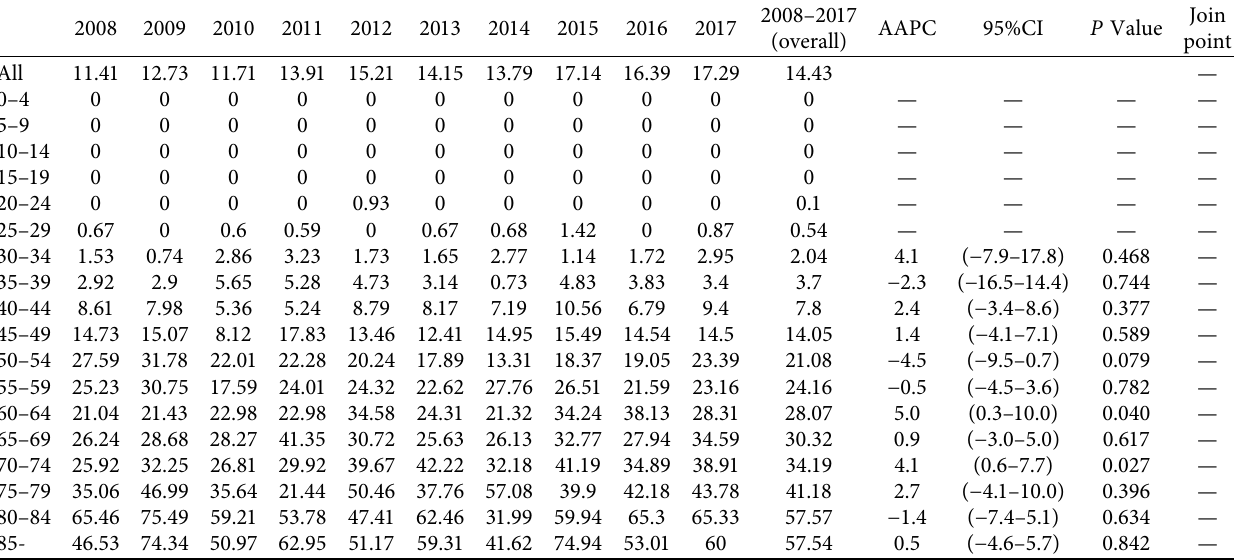
Table 8: Age-specific mortality of female breast cancer in urban Shenyang in 2008–2017.